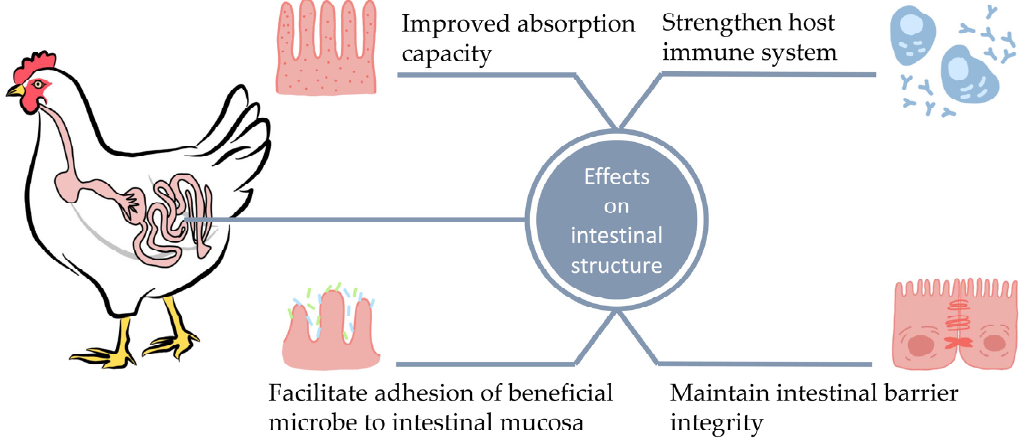
Figure 2. Effects of probiotics on intestinal health and immune function.